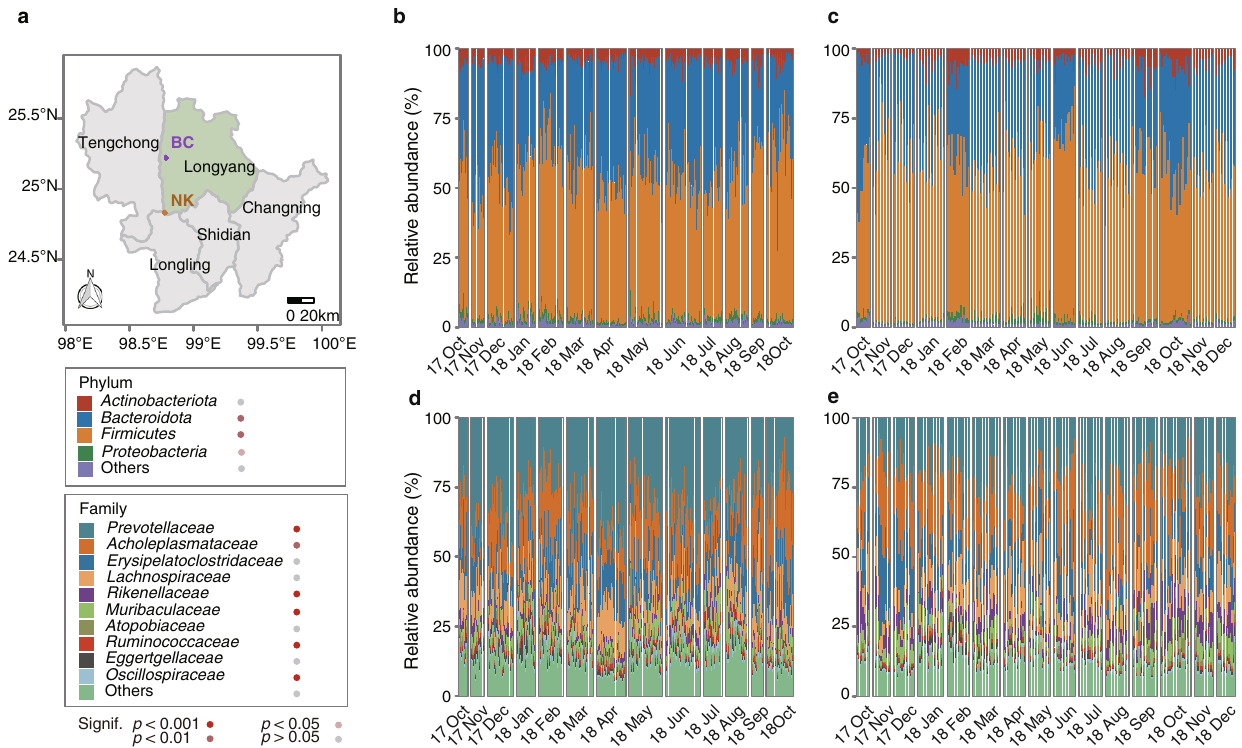
Fig. 1 Microbiome composition of 514 gibbon fecal samples. a Home ranges of two social groups Nankang (orange, NK) and Banchang (purple, BC) during sample collection. b – e Relative abundances of phyla ( b NK; c BC) families ( d NK; e BC). Samples were sorted by the sampling time. Each column represented one sample and samples from different months were separated by the blank space. Signi fi cance was calculated by the Wilcoxon rank-sum test with samples classi fi ed by social